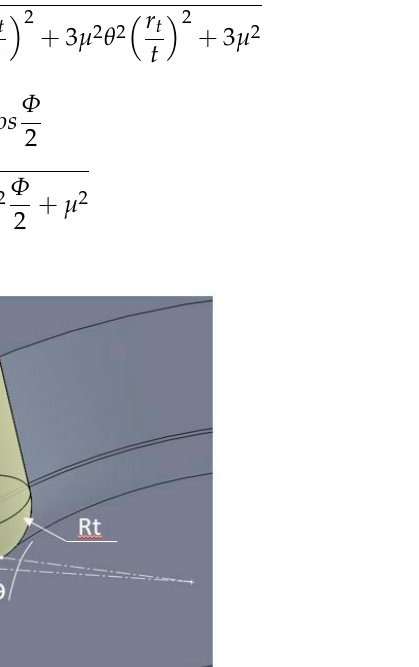
Figure 16. Relation between radial forces and test temperature.